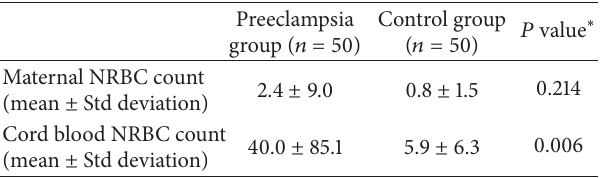
Table2:ComparisonofNRBCcounts/100leucocytesinpreeclamp- sia and control groups.